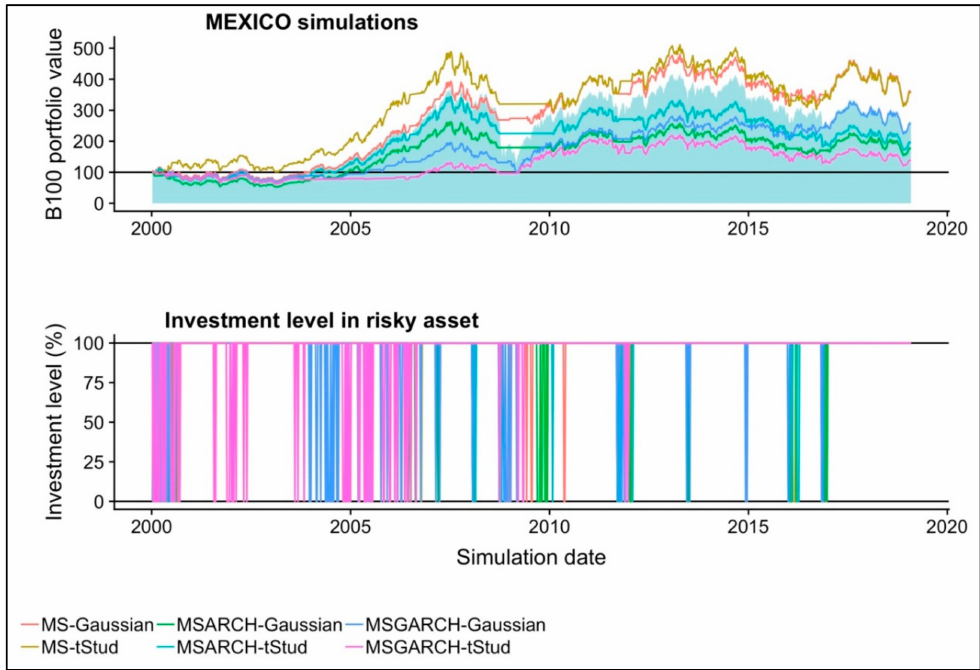
Figure 3. The historical performance of the six backtested portfolios in the Mexican stock